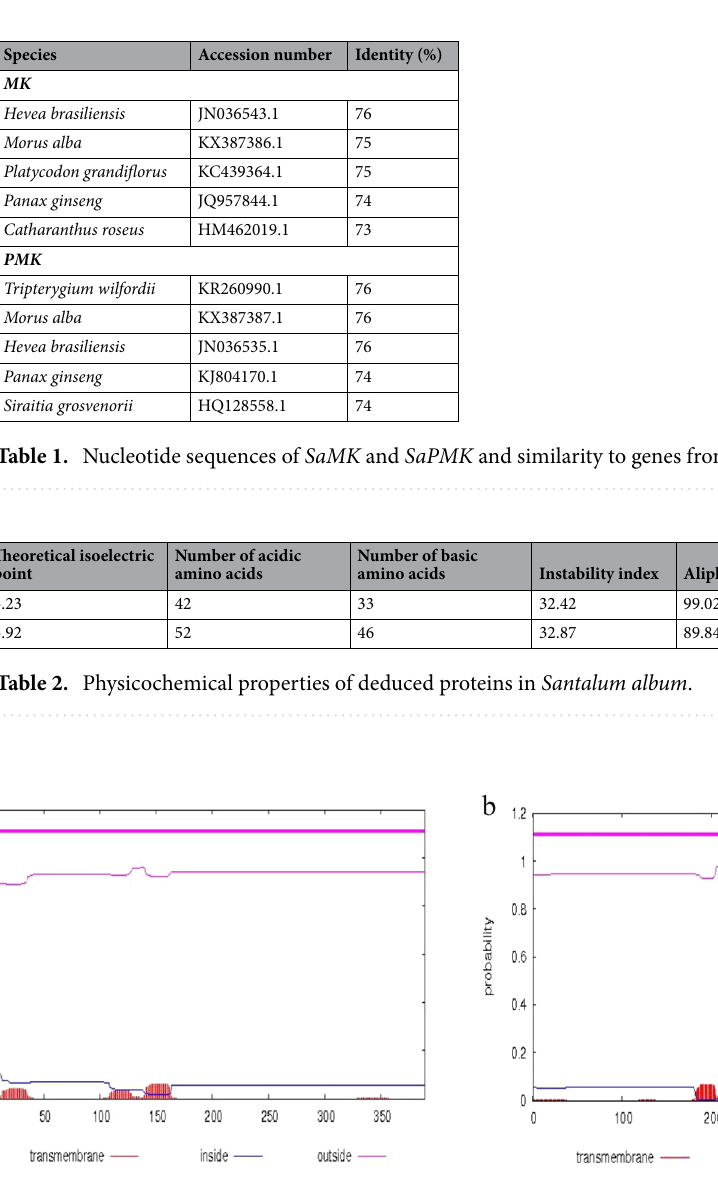
Figure 1. Prediction of transmembrane domains of SaMK ( a ) and SaPMK ( b ) proteins in Santalum album